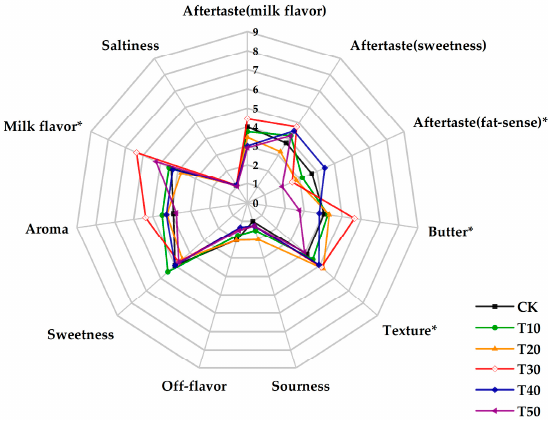
Figure 2. Sensory evaluation of the skim milk samples preheated for different time.